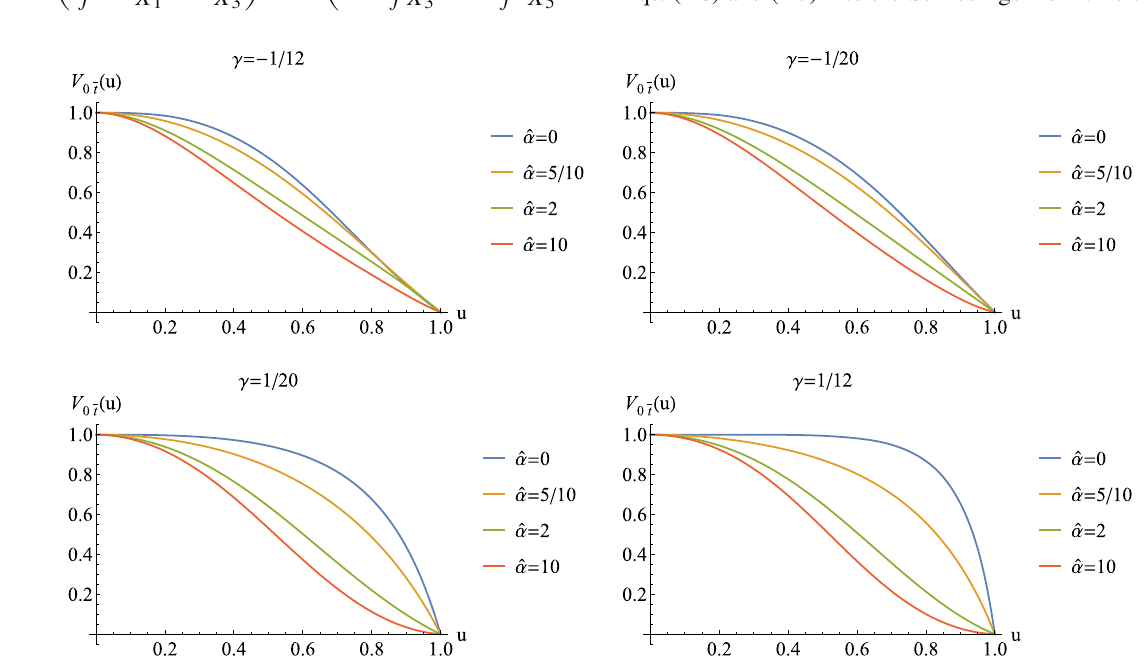
Fig. 13 The shape of the potentials V 0 ¯ t of the longitudinal mode A t for various value of γ ∈ S 0 and ˆ α is shown. We find that V 0 ¯ t well belongs to the region (A13). (For interpretation of the references to color in this figure, the reader is referred to the web version of this